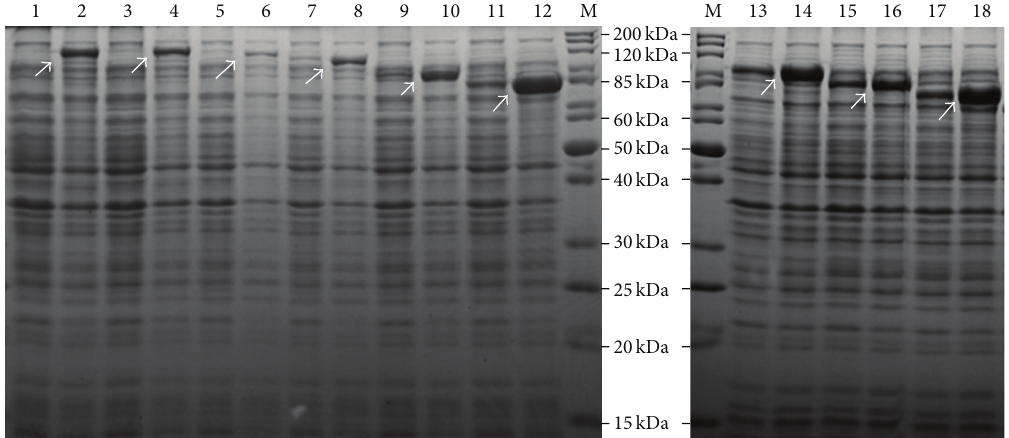
Figure 2: Coomassie stained gels demonstrating overexpression of recombinant Atl. The 12.5% SDS-PAGE contains protein extracts of E. coli BL21 cells with pRSETA plasmids expressing either full length or truncated Atl proteins. The odd number labels are cells grown without IPTG and the even number labels are the cells grown with IPTG. Lane M: standard protein markers; lanes 1 and 2 - Atl (full length His-tagged Atl); lanes 3 and 4: Atl-1; lanes 5 and 6: Atl-2; lanes 7 and 8: Atl-3; lanes 9 and 10: Atl-4; lanes 11 and 12: Atl-6; lanes 13 and 14: Atl-5; lanes 15 and 16: Atl-7; lanes 17 and 18: Atl-8. The Atl number suffixes are indicated in Table 1.